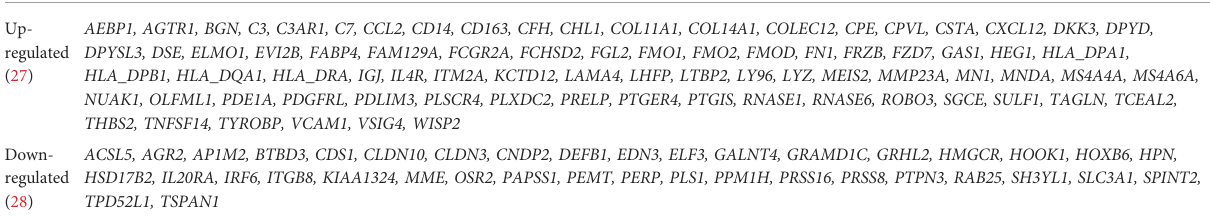
TABLE 2 The list of identi fi ed DEGs in three endometriosis datasets, GSE11691, GSE23339, and GSE7305. DEGs Gene